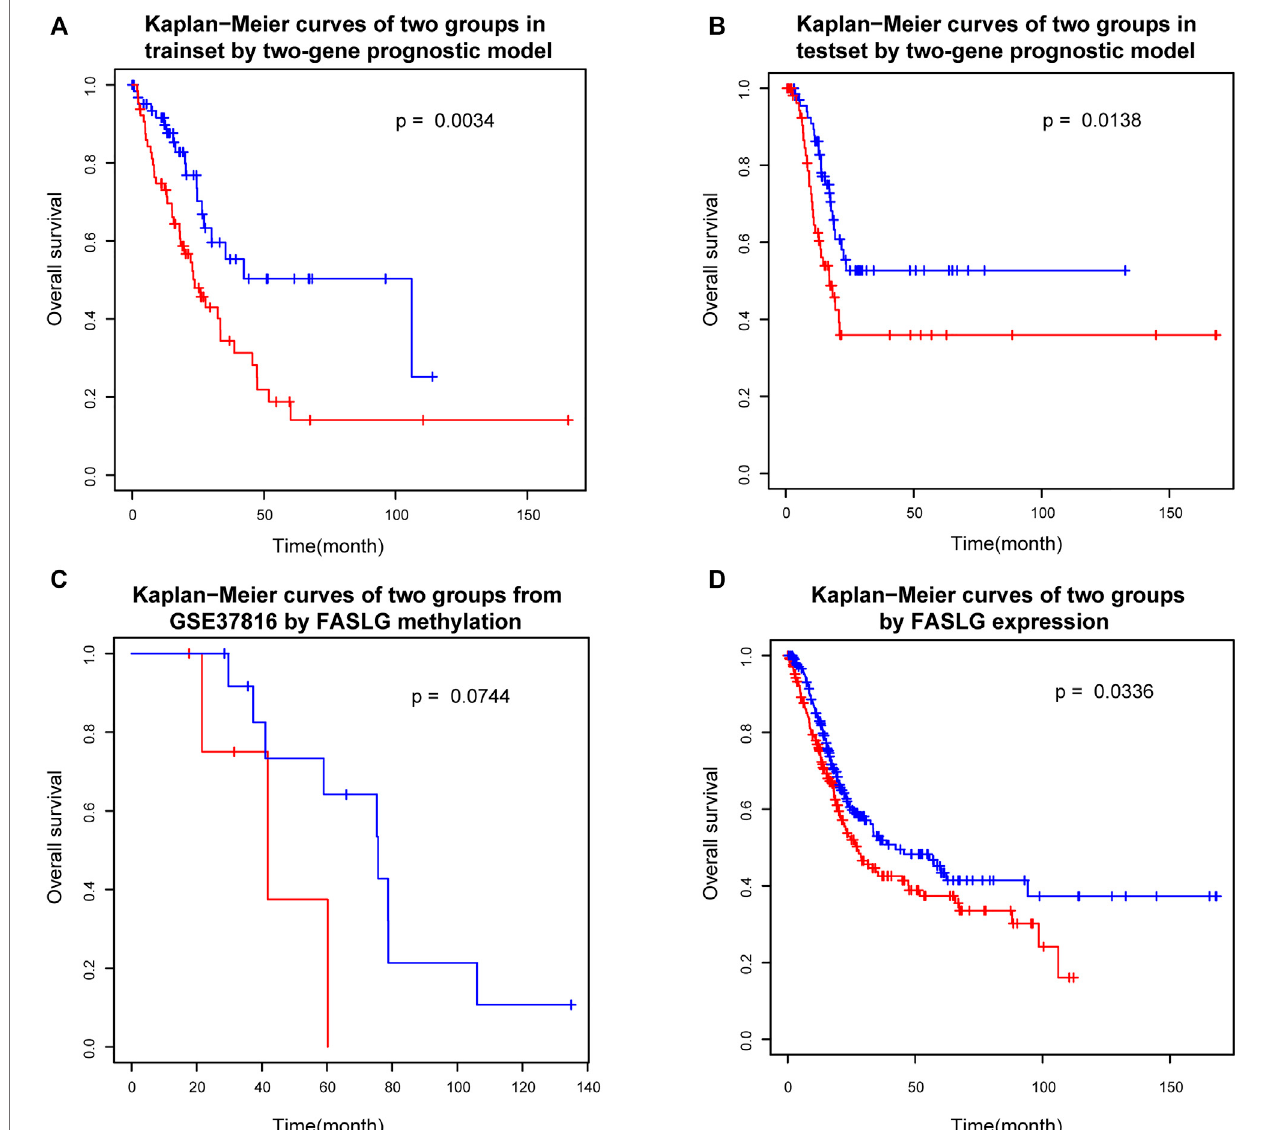
FIGURE 4 | Survival analysis of two groups. (A) Kaplan − Meier curves of two groups in trainset by two-gene prognostic model. (B) Kaplan − Meier curves of two groups in testset by two-gene prognostic model. (C) Kaplan − Meier curves of two groups from GSE37816 by FASLG methylation. (D) Kaplan − Meier curves of two groups by FASLG